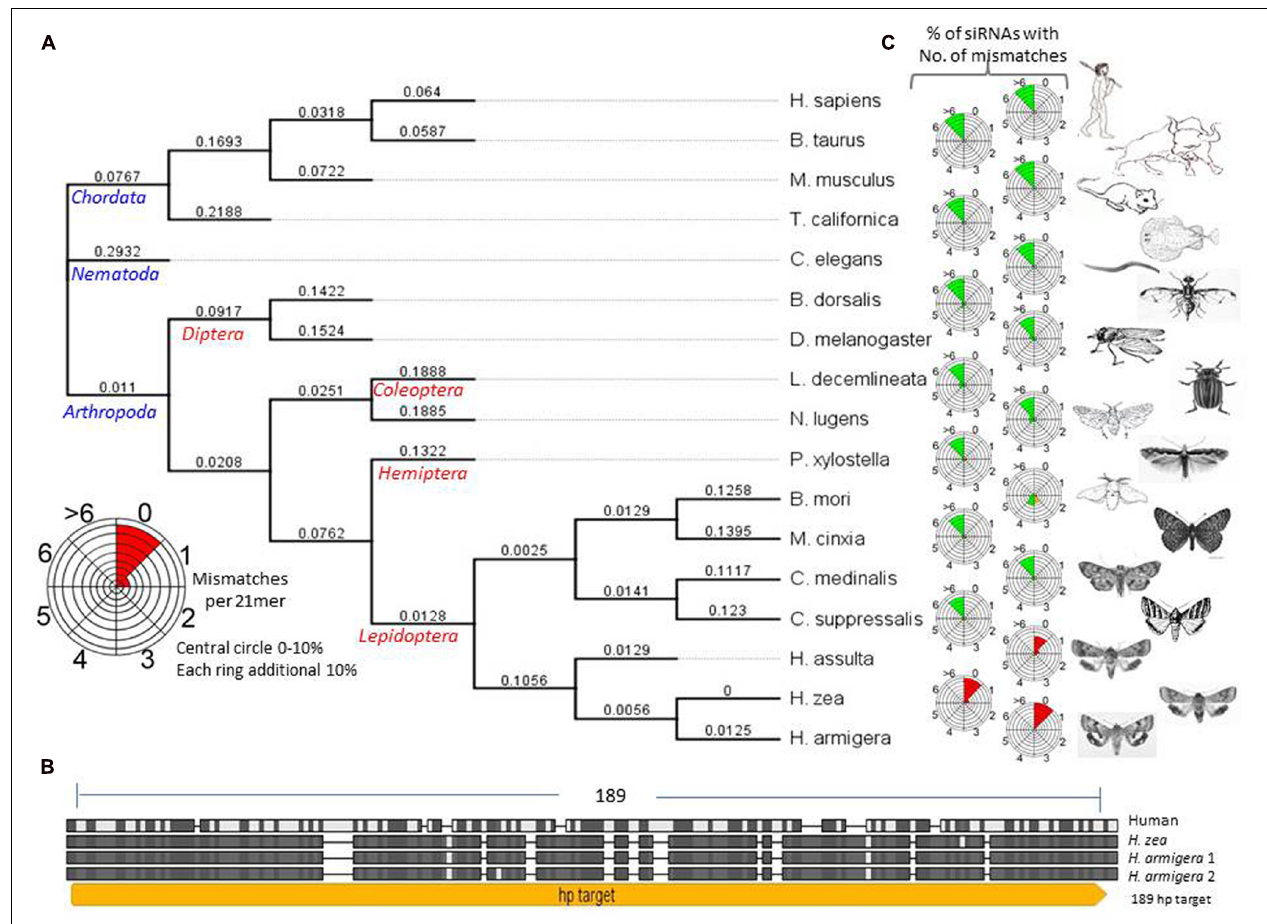
FIGURE 2 | (A) Acetylcholinesterase (ACE) phylogenetic tree based on nucleic acid sequences made with the neighbor-joining method. Bombyx mori ( B. mori ; DQ115792), Bos taurus ( B. Taurus ; NM_001076220), Caenorhabditis elegans ( C. elegans ; X75331), Drosophila melanogaster ( D. melanogaster ; X05893), Helicoverpa armigera (H. armiger; AF369793 ), Helicoverpa assulta ( H. assulta ; AY817736), Helicoverpa zea (Supplementary Figure S1), Homo sapiens ( H. sapiens ; M55040), Leptinotarsa decemlineata ( L. decemlineata ; L41180), Mus musculus ( M. musculus ; X56518), Nilaparvata lugens ( N. Lugens ; AJ852420), Torpedo californica ( T. californica ; X03439 ) , Chilo suppressalis (C. supressalis ; EF470245.1) , Cnaphalocrocis medinalis (C. medinalis ; FN538987.1) , Melitaea cinxia (M. cinxia ; GQ489250.1) , Plutella xylostella (P. xylostella ; AY032625.1). (B) H. armigera ACE nucleotide sequence showing the hairpin target site, alignment of ACE1 nucleotide sequences from H. sapiens , H. zea , H. armigera and ACE2 of H. armigera . Conserved residues are enclosed in black/gray boxes, hairpin target region indicated in yellow (hp189). See Supplementary Figure S1 for details of sequence. (C) Radial siRNA relationship icons for each species calculated by TK-siRNA software at benthgenome.com. They indicate the percentage of possible siRNAs from the H. armigera ACE hpRNA sequence that have 0, 1, 2, 3, 4, 5, 6, or > 6 mismatches with the corresponding gene in the different species. Twenty-one nucleotides of siRNA sequences with 0, 1, or 2 mismatches are expected to target cleavage of the target gene (and shown in red), those with > 3 mismatches are shown in green and expected to have no significant RNAi effect. Those shown in orange are placed in the category of possibly having an RNAi effect. Each successive circle represents a 10% bin from 0–10 to 90–100%. For example: a completely red sector for 0 mismatches (e.g., for H. armigera ) represents 100% of the potential siRNAs are predicted to direct an RNAi effect and a completely green sector for > 6 mismatches (e.g., for H. sapiens ) represents 100% of the potential siRNAs are predicted to not direct an RNAi effect. The prediction about degrees of mismatch having an RNAi effect comes from the results shown in Supplementary Figure